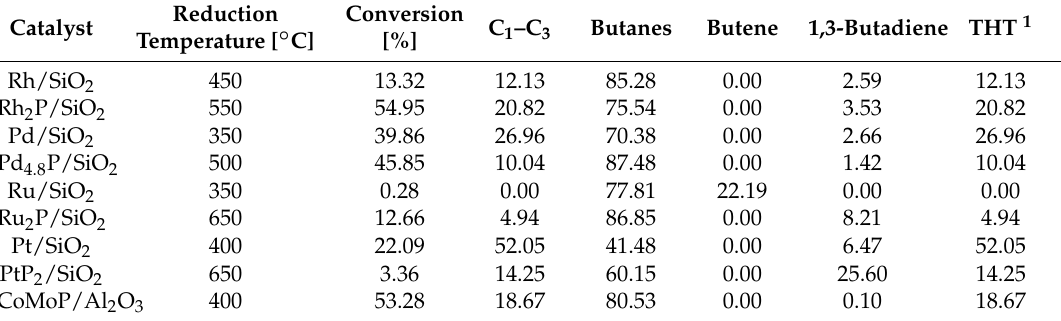
Table 5. Performance of different PMG metals and phosphides in the HDS of thiophene